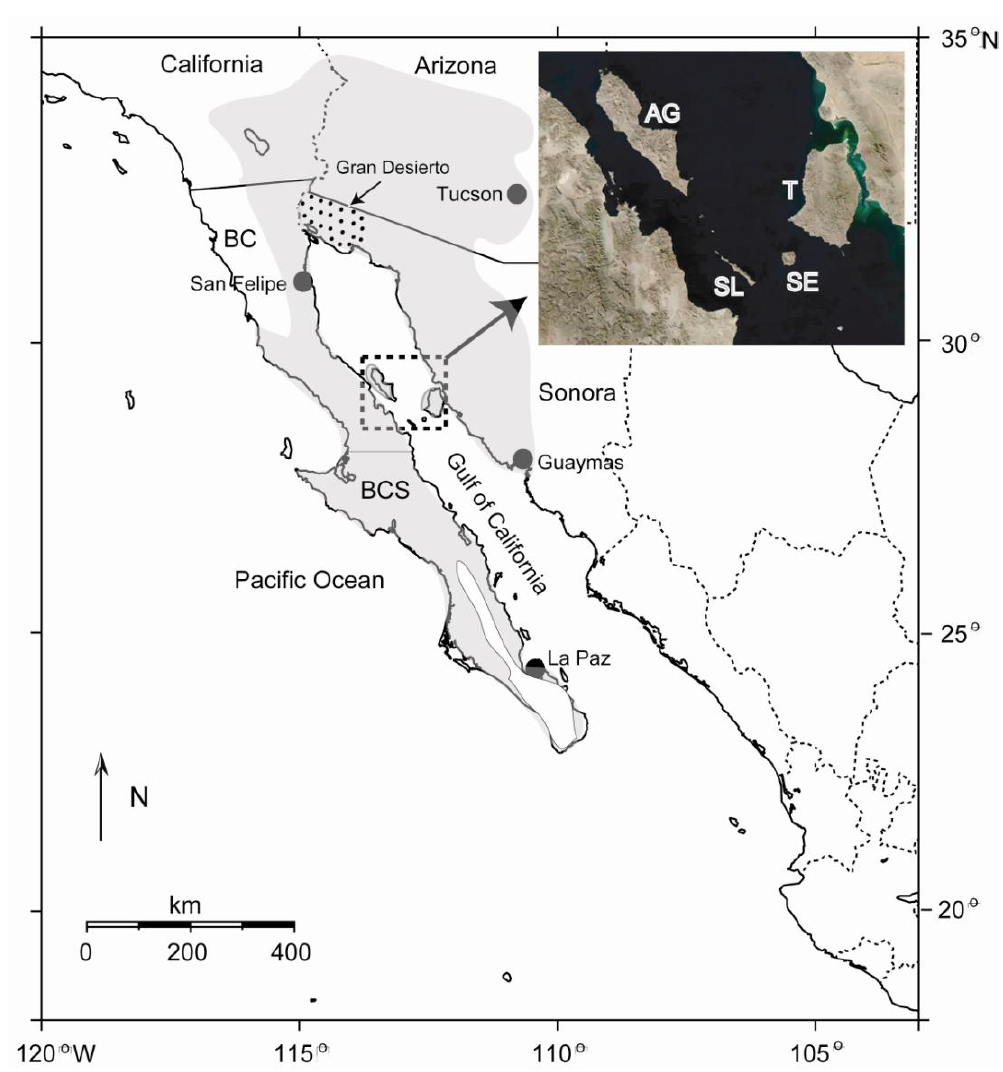
Figure 1. Map showing the approximate boundaries of the Sonoran Desert (shaded area) in 69 southwestern USA and northwestern Mexico. Inset is a satellite image showing details of 70 the four major Midriff Islands in the Gulf of California: AG, Angel de la Guarda; T, 71 Tiburón; SE, San Esteben; SL, San Lorenzo. Stippled area at the head of the Gulf shows 72 the region of the Gran Desierto de Altar. BC, Baja California; BCS, Baja California